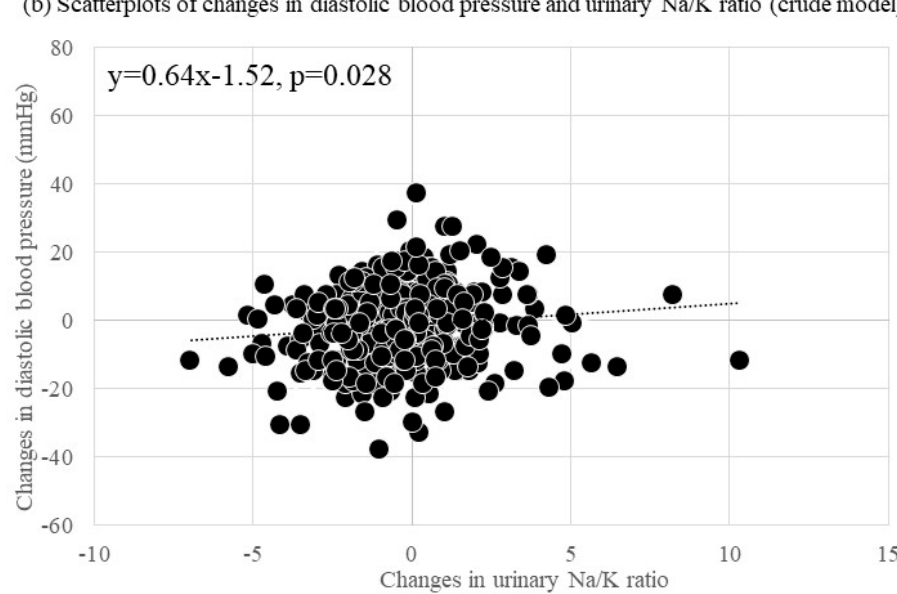
Figure 1. Scatterplots of changes in blood pressure and the urinary Na/K ratio